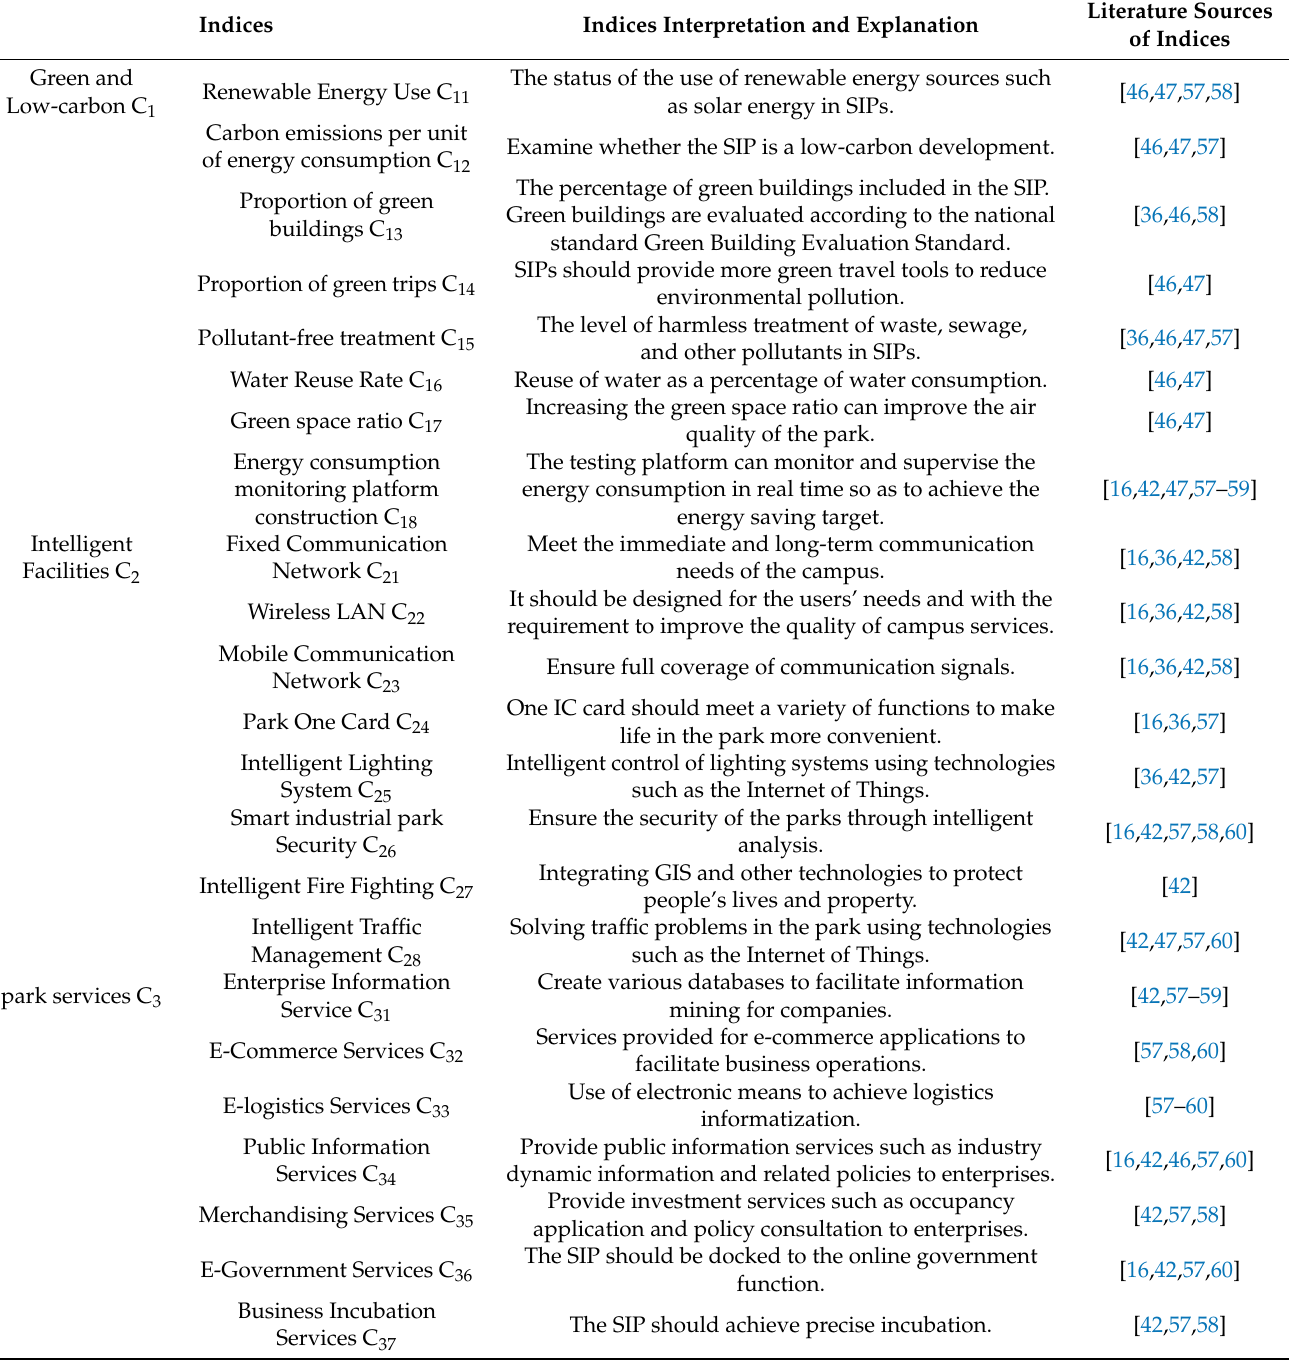
Table 4. Evaluation indicators for measuring intelligent performance of